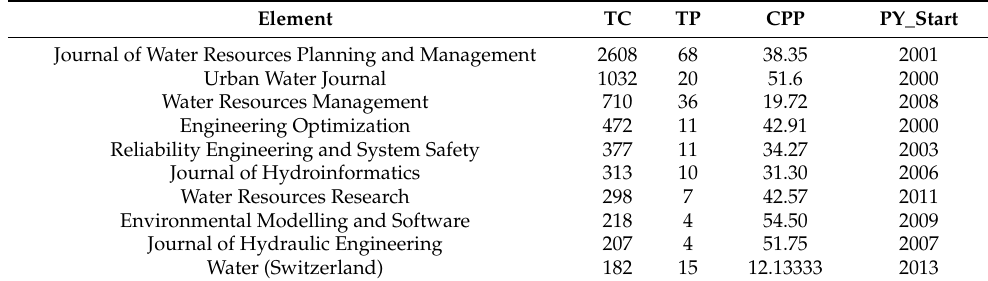
Table 4. Top ten most cited